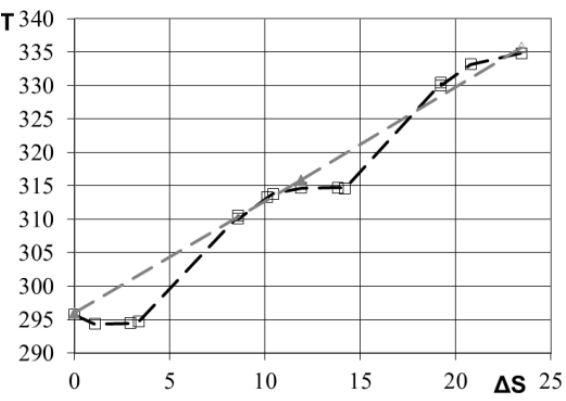
Figure 5. T S  —gas flow diagram of the two-stage pipeline compressor (design flow rate). Figure 5. T − S—gas flow diagram of the two-stage pipeline compressor (design flow rate). (cid:3) —MM □—MM calculation, Δ—constant polytropic index [30] . calculation, ∆ —constant polytropic index [30].